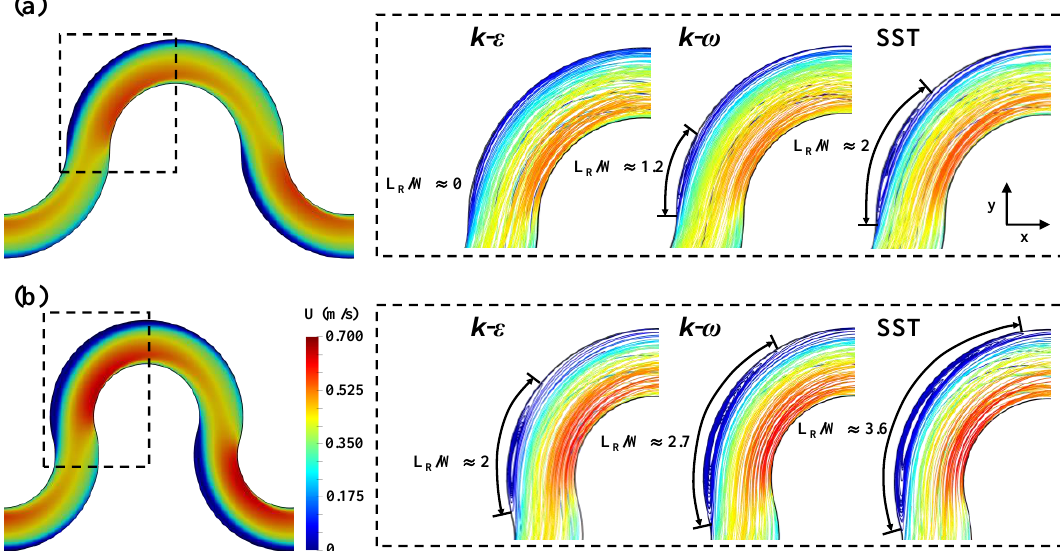
Figure 6. Streamlines of velocity fields for ( a ) S157 and ( b ) S190, simulated with different turbulence models. L R indicates the reattachment length of recirculation zones.